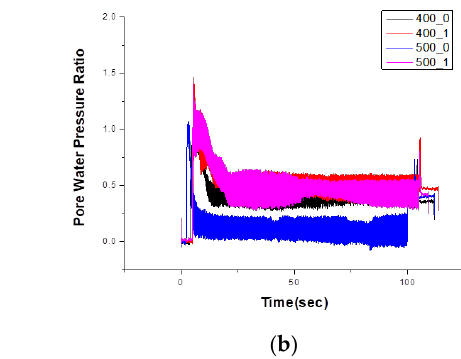
Figure 17. Pore Water Pressure of grouting mixing ratio and separation distance. ( a ) Pore Water Pressure of grouting mixing ratio. ( b ) Pore Water Pressure of separation distance.